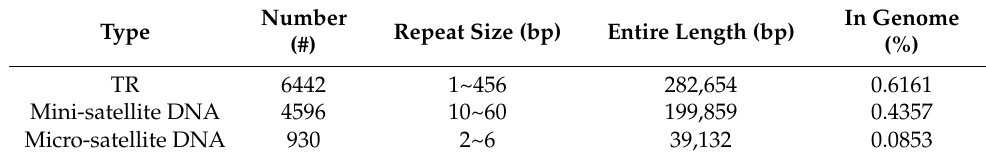
Table 3. A. rasikravindrae genome data related tandem repeat sequences (TRs).